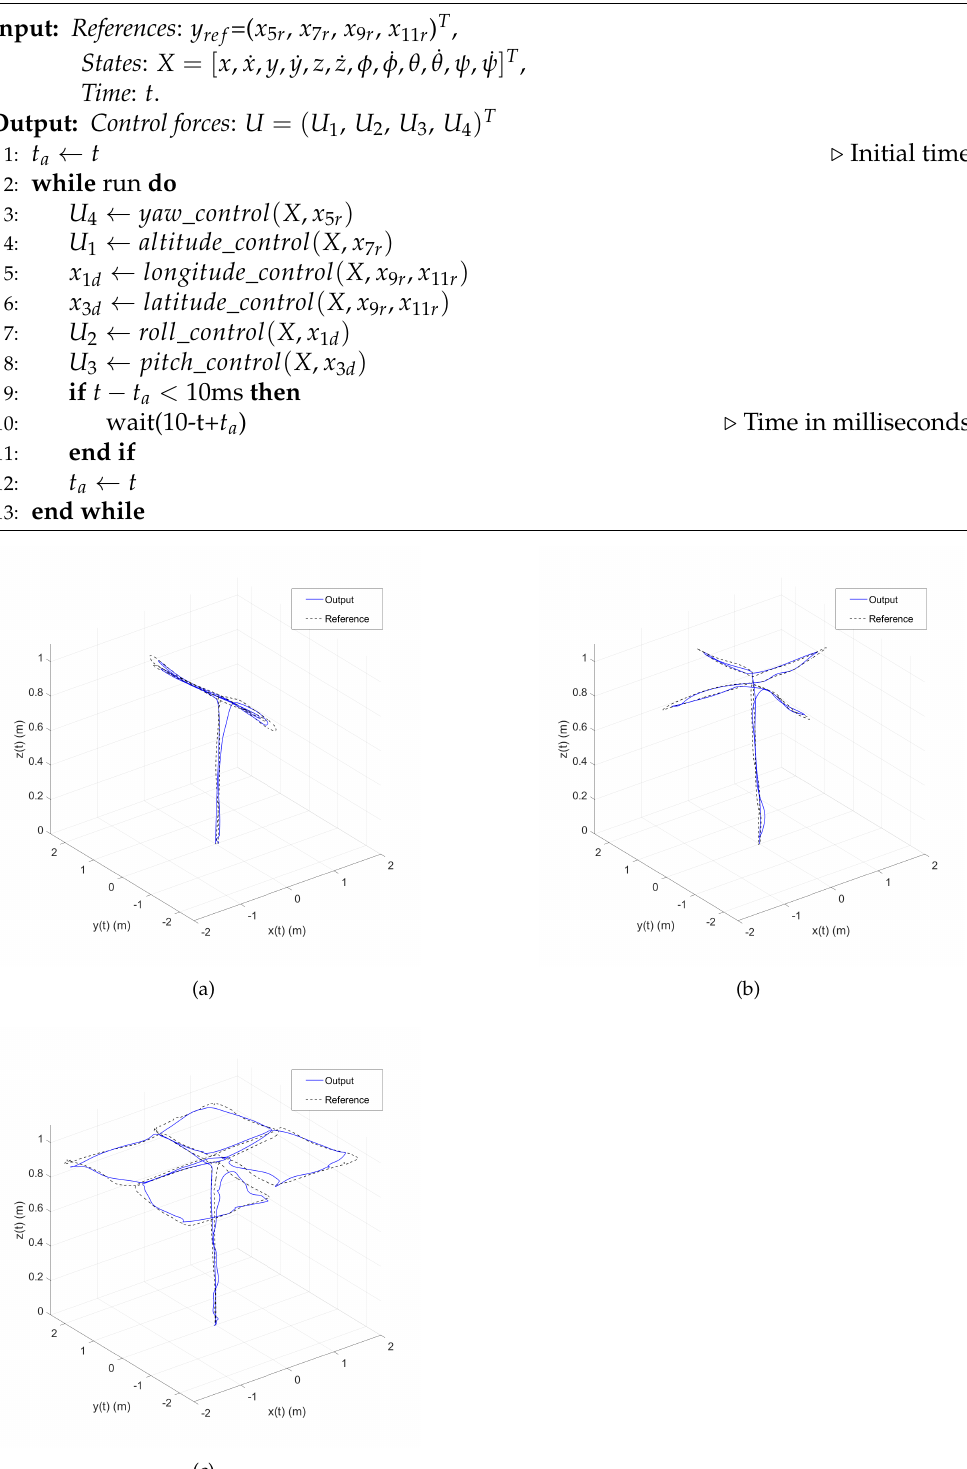
Algorithm 4 Embedded control for HIL simulation